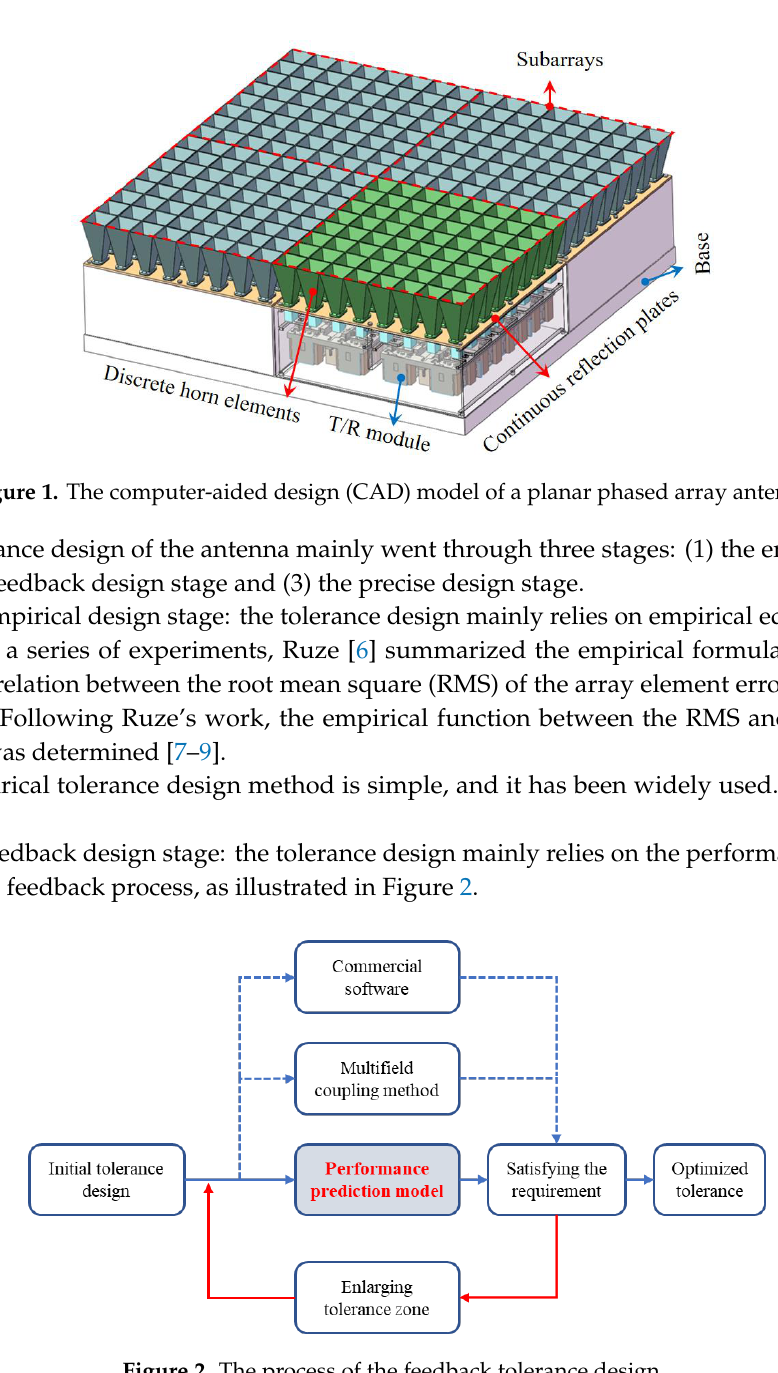
Figure 2. The process of the feedback tolerance design.